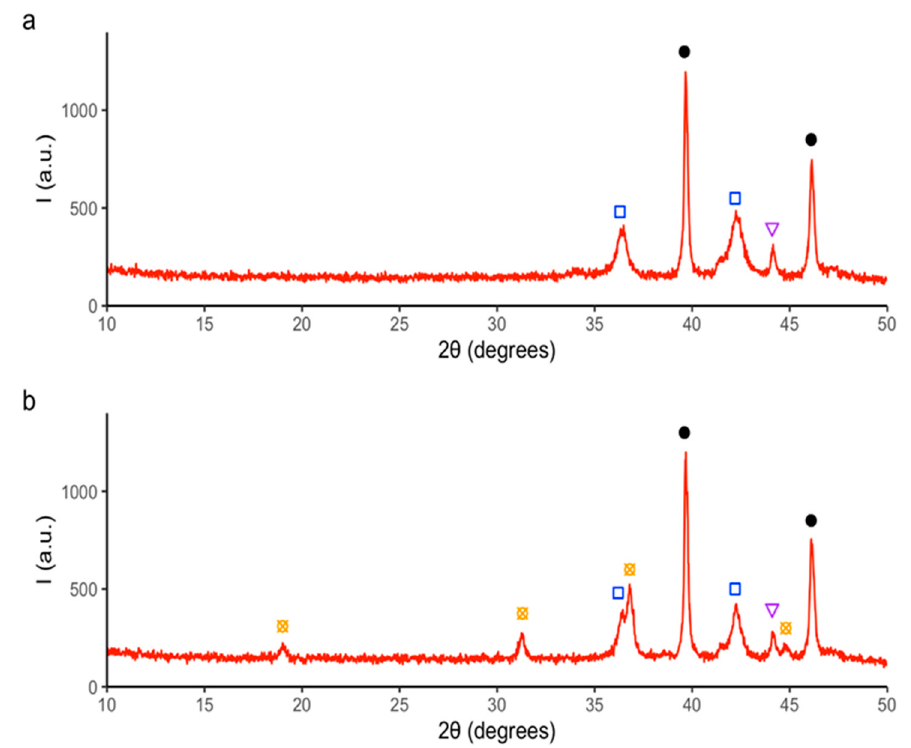
Figure 9. X-ray powder diffraction of cobalt acetate tetrahydrate heated under N 2 atmosphere at 400 ◦ C. The sample was kept at 400 ◦ C while several scans were measured. Starting time difference between the first ( a ) and the last one ( b ) was 27 min. Main peaks of identified phases are marked as follows: black circle for platinum (PDF-01-087-0642), blue square for CoO rocksalt polymorph (PDF 00-048-1719), purple inverted triangle for Co (PDF-01-089-4308), and orange crossed circle for Co 3 O 4 (PDF-01-086-8289).